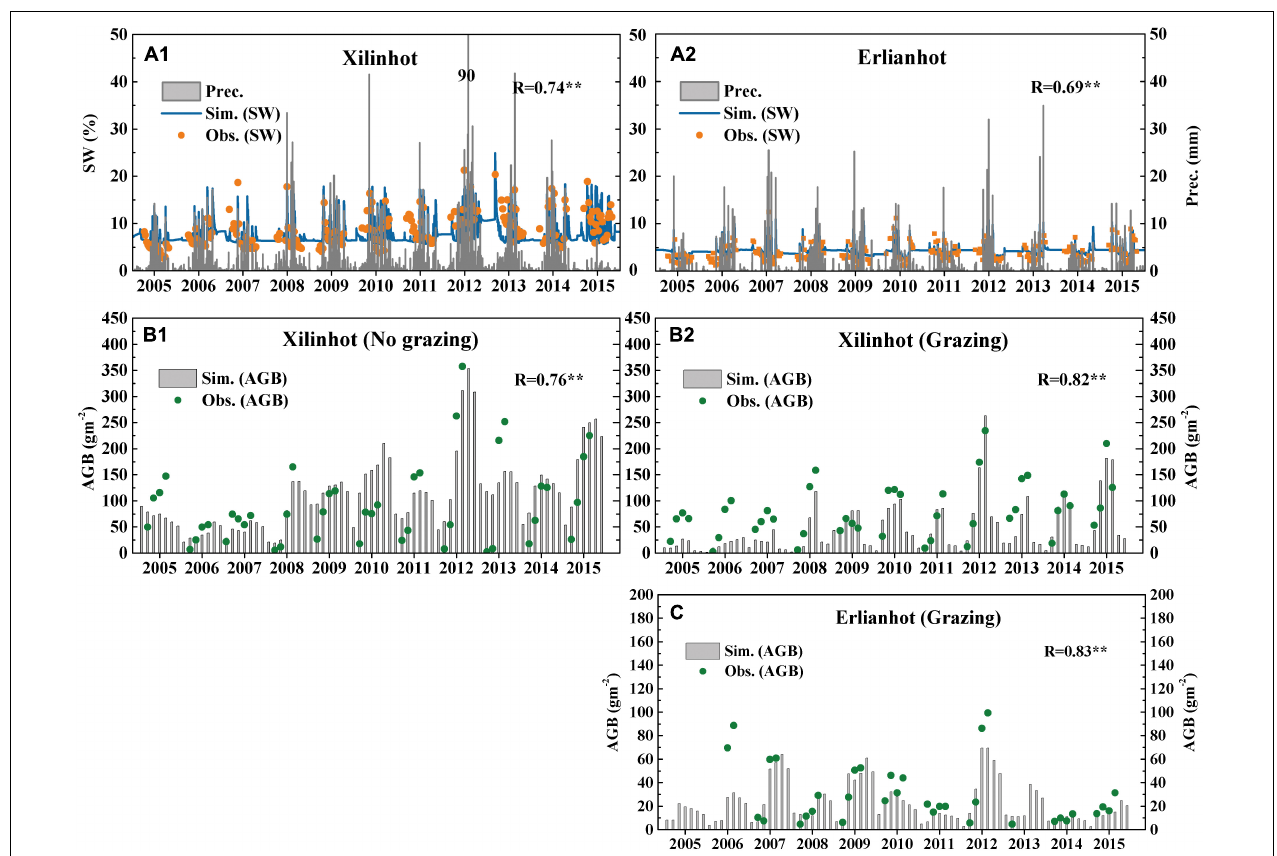
FIGURE 2 | (A) Comparison of daily precipitation (Prec.), 10-day observed (depth 10.0 cm) and daily simulated (depth 7.5 cm) SW (The maximum value of y-axis precipitation is 90 mm. In order to clearly indicate the SW, the maximum value is limited to 50 mm); observed and model simulated aboveground biomass (AGB) in Inner Mongolian Xilinhot station (B) and Erlianhot station (C) . **Indicates significant at the 1%